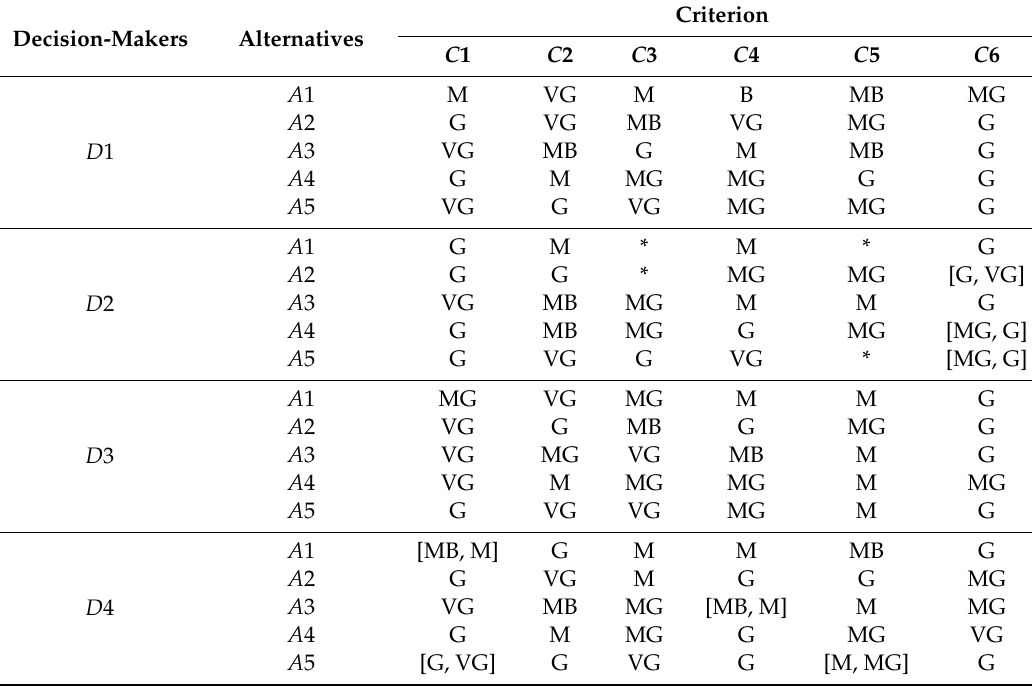
Table 2. Criterion rating values for five